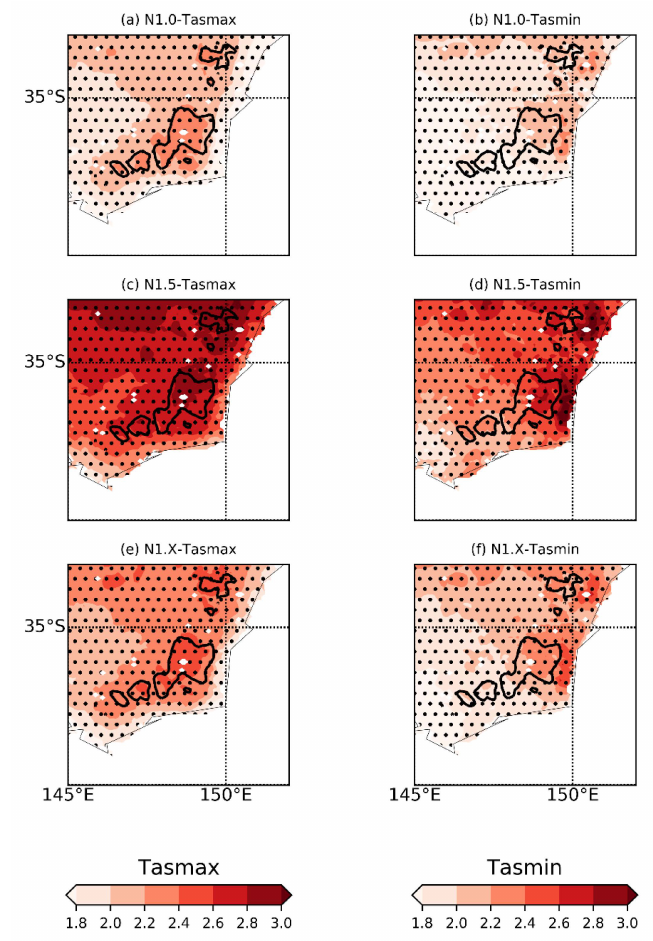
Figure 4. Projected changes in annual mean of maximum and minimum temperatures for N1.0, N1.5 and N1.x for 2060–2079 relative to 1990–2009 (unit: ◦ C). Stippling indicates statistically significant changes using a non-parametric Mann-Kendall test at the 95% confidence level. The black solid lines are the 1200 m contour where the high elevation areas